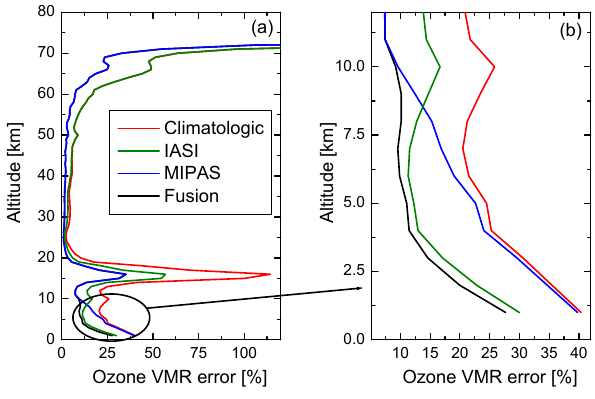
Fig. 9. Percentage retrieval errors for the profiles retrieved from real measurements using only the IASI measurement (green line), only the MIPAS measurement (blue line) and the IASI-MIPAS data fusion. The standard deviation of the climatological profile (red line) is also reported. (b) shows a blow up of (a) in the low altitude